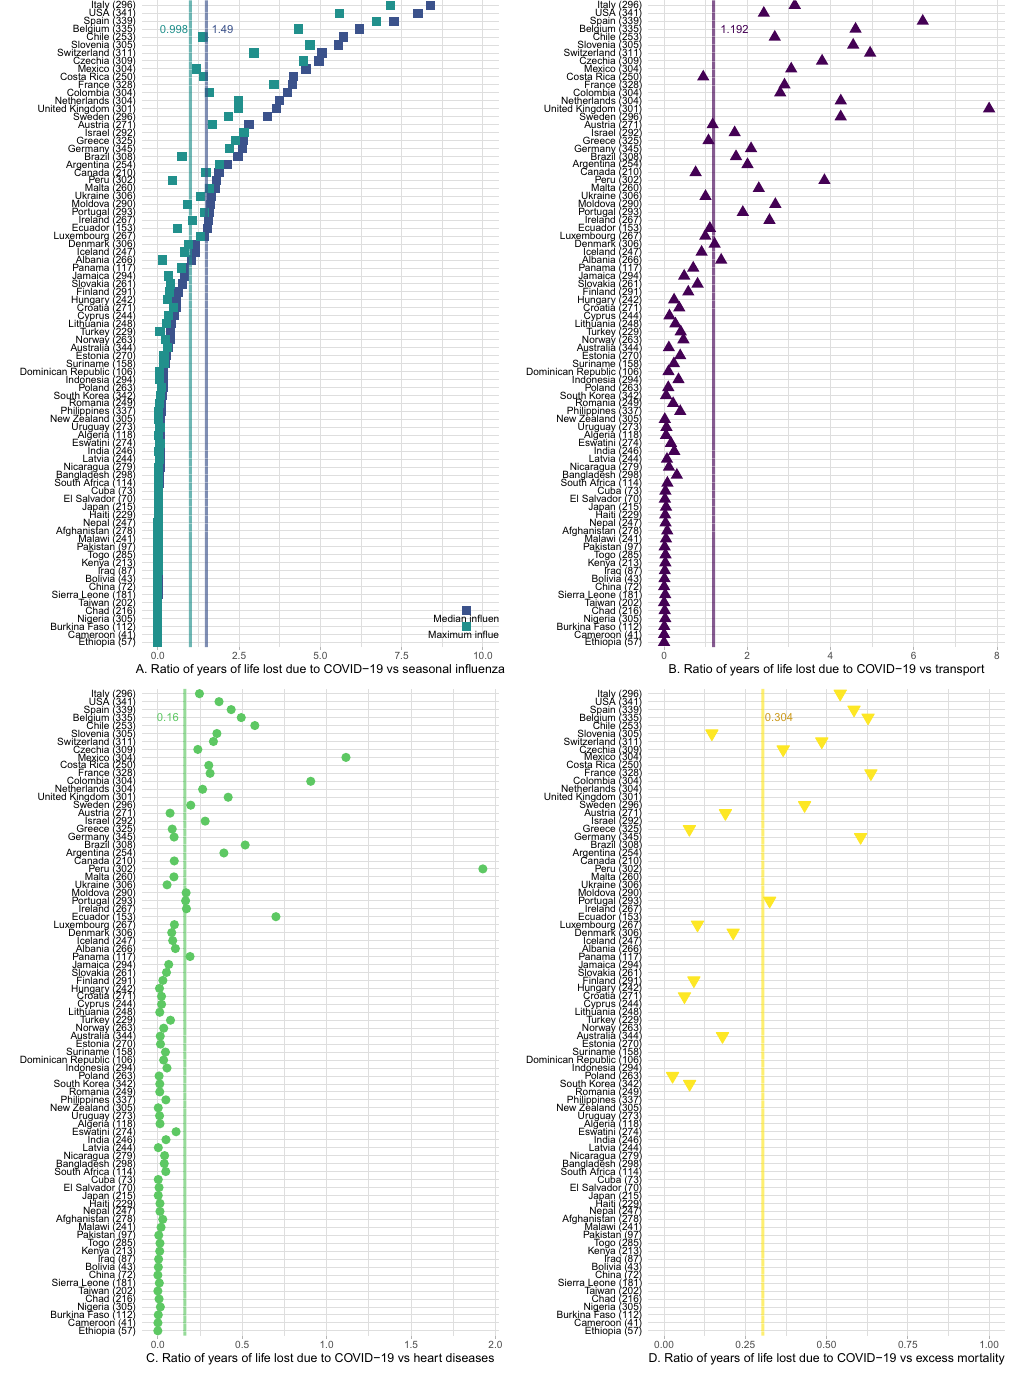
Figure 1. Panels A through C report the ratio of COVID-19 YLL rates over influenza YLL rates (in median/ maximum deadly years by country), traffic accidents, and heart conditions respectively. Panel D reports, countries with available data, the ratio of YLL rates of COVID-19 deaths over YLL rates of excess deaths. When two causes of mortality affect YLL equally, the ratio is precisely 1; larger ratio values suggest COVID-19 YLL rates are higher than the alternative cause. Average ratios in vertical lines in each panel. Each country name is followed by (in parentheses) the number of days passed since the country’s first official COVID-case up to the last day of available COVID-19 deaths data for that country. Countries always sorted by ratio of COVID-19 YLL vs seasonal flu (in median years) across panels for ease of